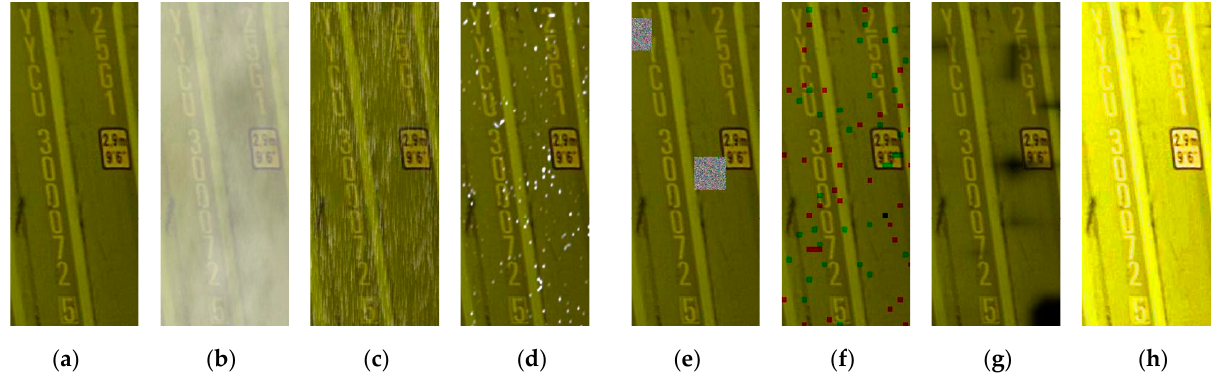
Figure 4. Data enhancement results of the sample set: ( a ) original drawing, ( b ) simulating foggy days, ( c ) simulating rainy days, ( d ) simulating snow days, ( e ) foreign bodies blocked 1, ( f ) foreign bodies blocked 2, ( g ) simulating smoke, ( h ) simulating strong light.